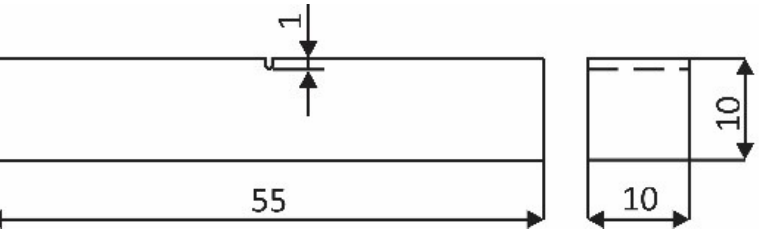
Figure 3. Geometry of the specimen for fatigue growth tests according to Standard ASTM E647-15e1 [45].